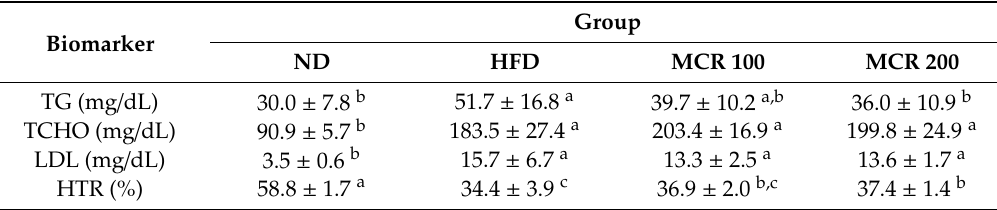
Table 1. Effect of Mori Cortex radicis extract (MCR) on serum biomarkers in HFD-induced (High Fat Diet-Induced) mice.